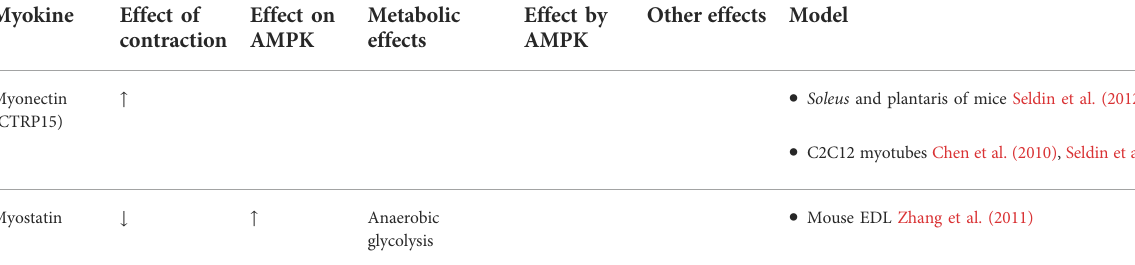
↑ indicates increase, ↓ indicates decrease, and * indicates uncon fi rmed